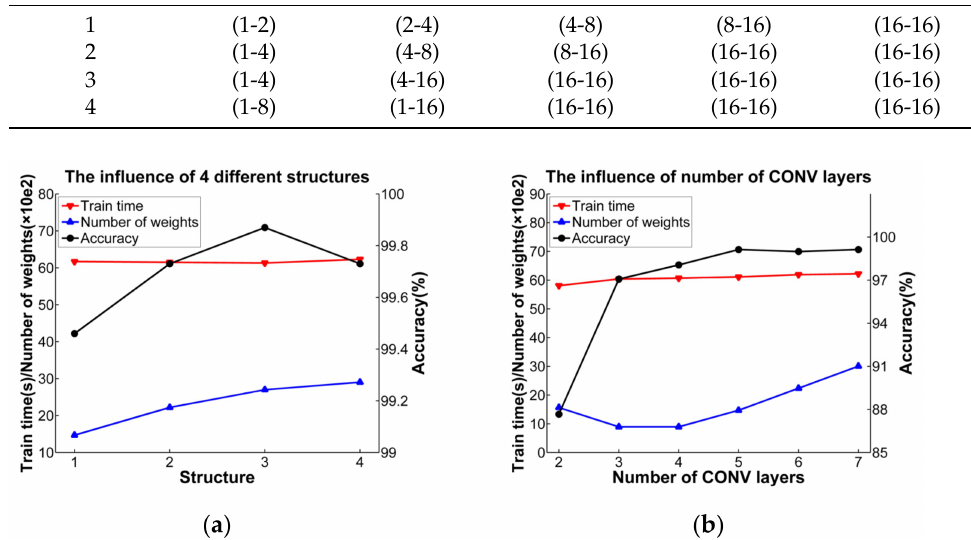
Figure 9. The influence of 4 different structures and the number of CONV layers. ( a ) The influence of 4 different structures. ( b ) The influence of the number of CONV layers.